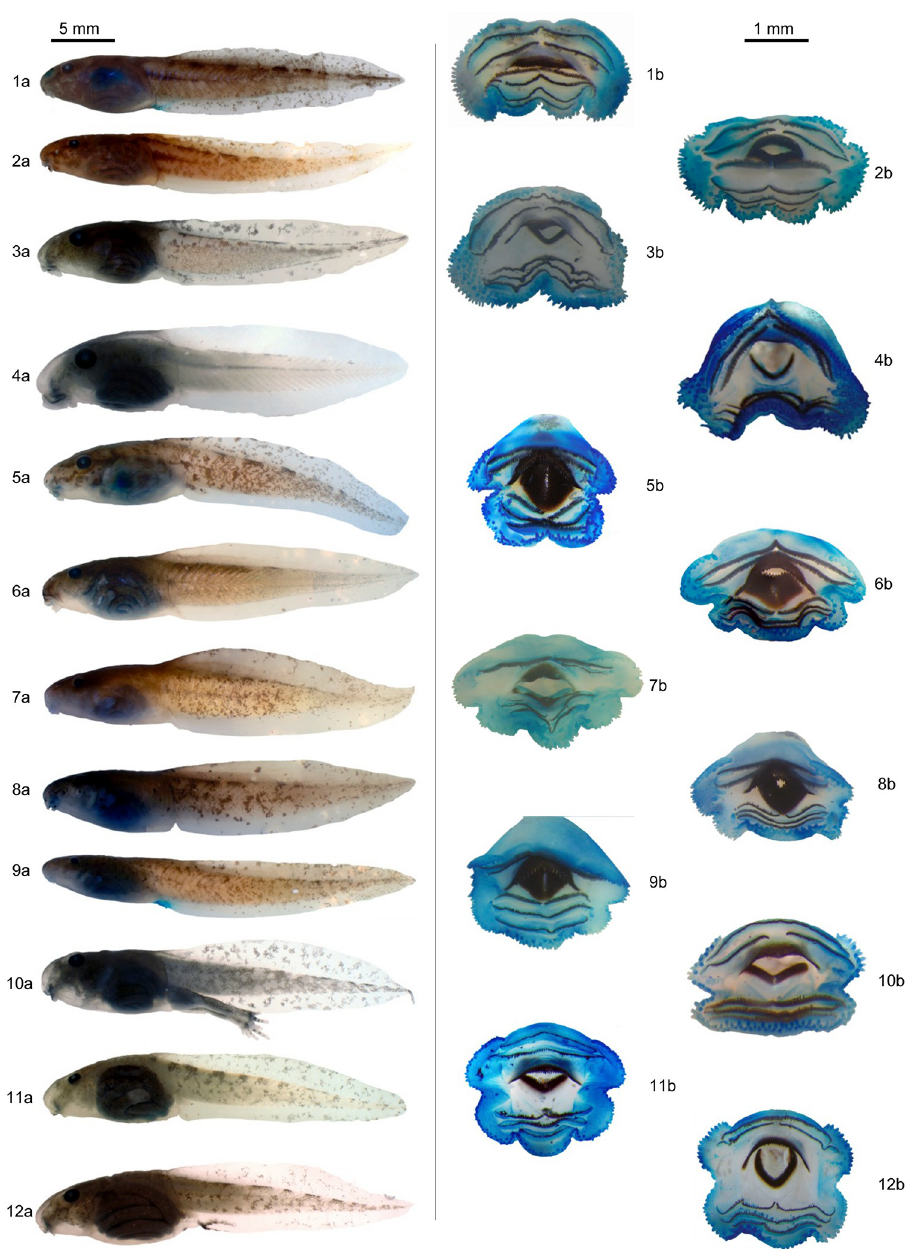
Fig 2. Tadpoles. Lateral view (a) and oral disk (b) of 1. Aplastodiscus arildae ; 2. Bokermannohyla circumdata ; 3. Scinax albicans ; 4. Scinax flavoguttatus ; 5. Crossodactylus aeneus ; 6. Hylodes asper ; 7. Hylodes charadranaetes ; 8. Hylodes lateristrigatus ; 9. Hylodes pipilans ; 10. Physalaemus signifer ; 11. Proceratophrys appendiculata ; and 12. Proceratophrys boiei